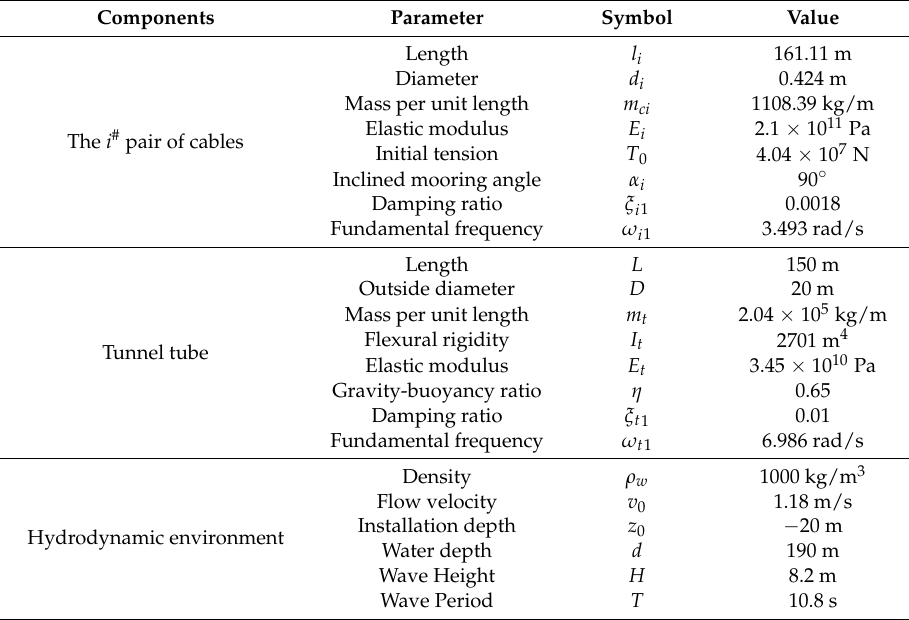
Table 1. Basic parameter settings of the submerged floating tunnel (SFT) model.